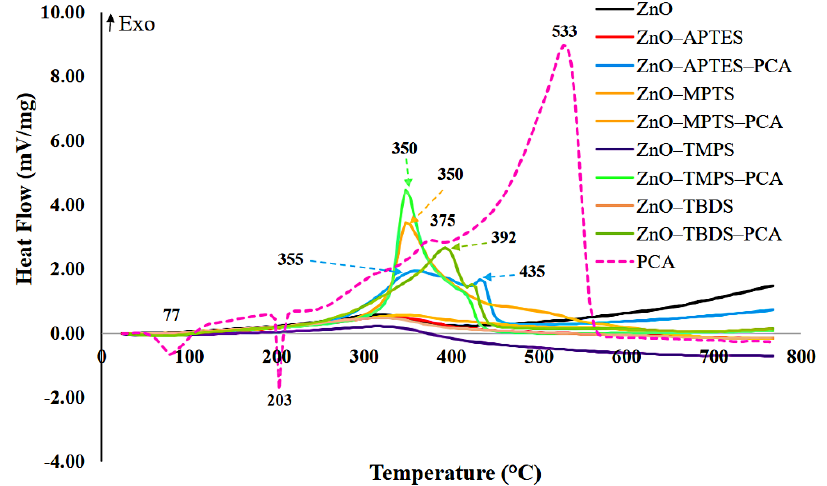
Figure 3. Differential scanning calorimetry analysis of ZnO NPs and surface-functionalized NPs. An exothermic process associated with mass loss is indicated. exothermic process associated with mass loss is